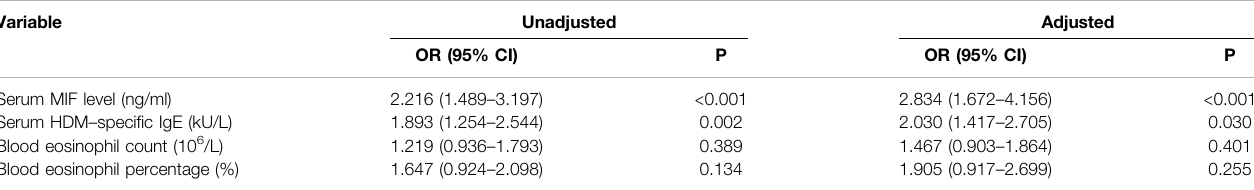
TABLE 6 | Unadjusted and adjusted logistic regression models for predicting clinical ef fi cacy of SLIT. Variable Unadjusted Adjusted OR (95% CI) P OR (95% CI) P Serum MIF level